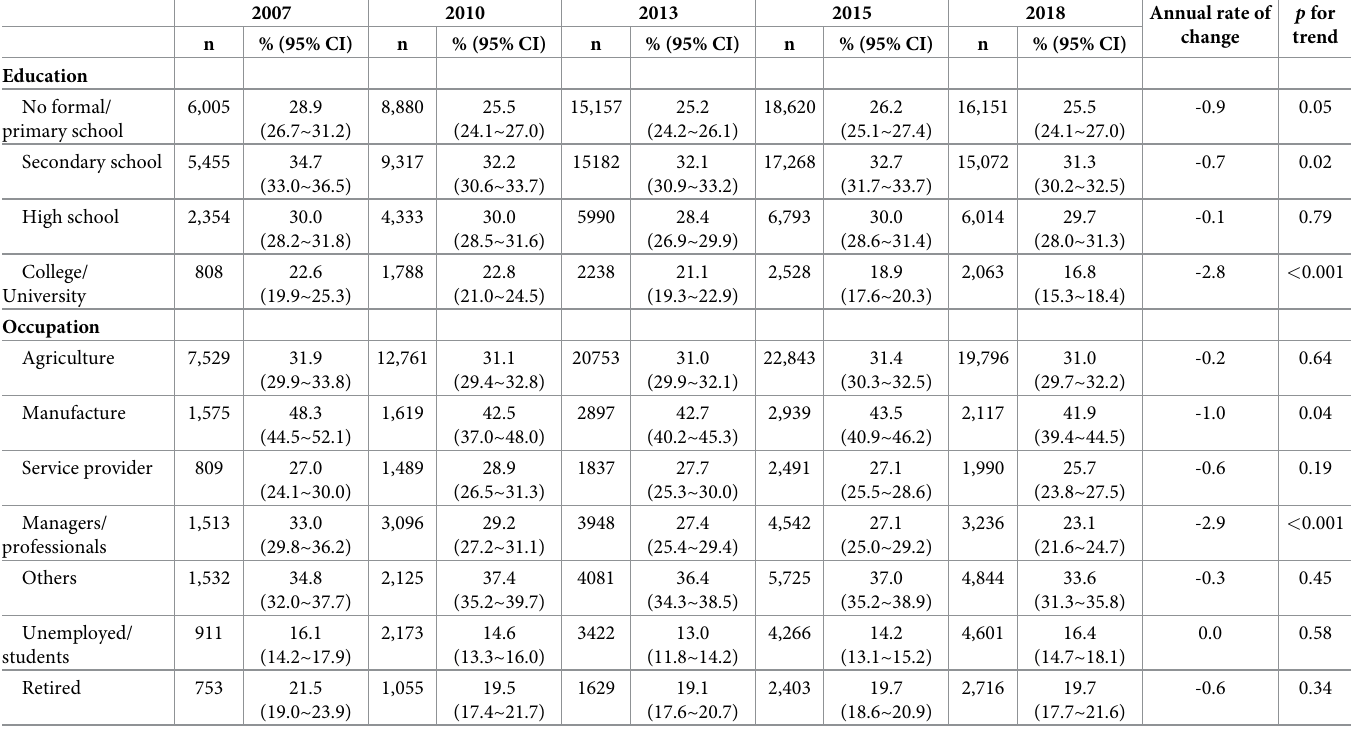
Among male smokers, the quitting ratio increased slightly from 11.3% (95% CI: 10.1 to 12.6) in 2007 to 13.4% (95% CI: 12.6 to 14.1) in 2018 ( p for trend = 0.01; Table L in S3 Text ). Although the quit ratio slightly increased in those aged 50 to 59 years ( p for trend = 0.009) and 40 to 49 years ( p for trend = 0.03), overall there was no statistically significant difference between age groups. No significant changes of current smoking prevalence (53.9% [95% CI: 51.3 to 56.6] to 50.8% [95% CI: 49.0 to 52.2], p for trend = 0.22) were observed in male patients with at least 1 of major chronic diseases (e.g., hypertension, diabetes, myocardial infarction, stroke, COPD). A decrease of current smoking prevalence was observed among urban men with COPD (66.8% to 48.3%, p for trend < 0.001), but no significant changes were observed in those who had other prior medical history of chronic diseases (all p values > 0.05; Tables M and N in S3 Text ).